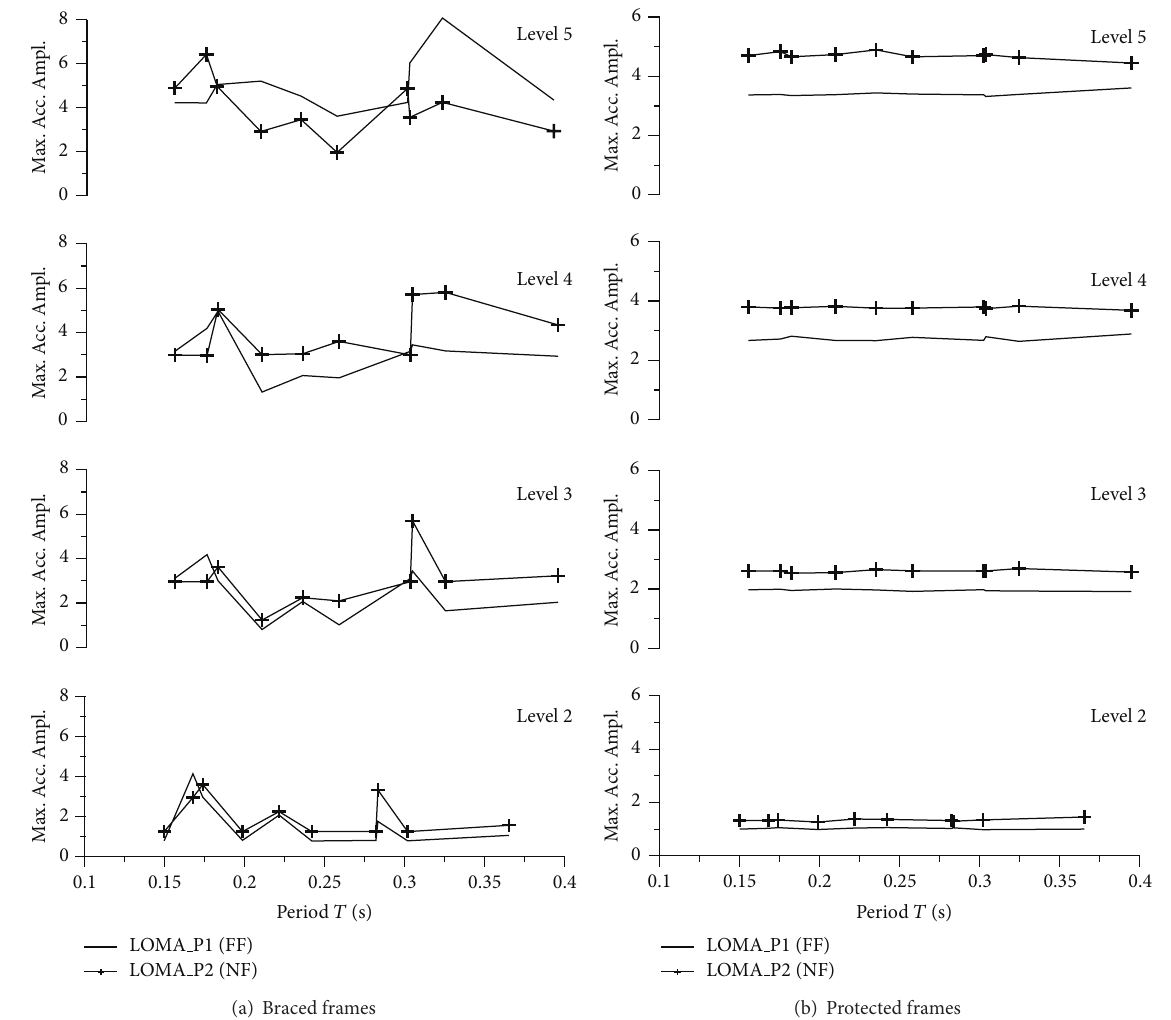
Figure 10: Maximum acceleration amplification for (a) braced frames and for (b) protected